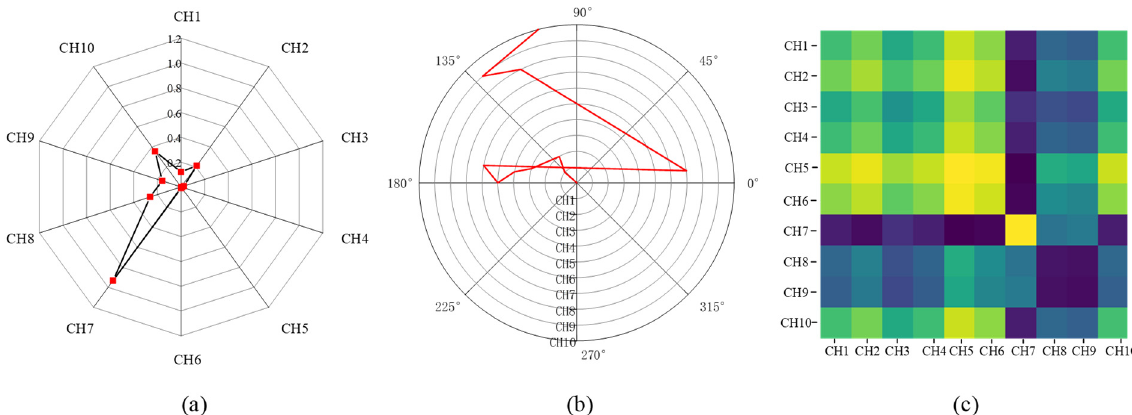
Figure 2. The proposed encoding procedure of GAF conversion on a selected moment: ( a ) normalized 10-channel sEMG values in radar map; ( b ) represented angular values in the polar coordinate system; and ( c ) demonstration of sEMG-GAF image after signal conversion. The different colors in ( c ) indicate relationships between the instant values in different sensors.